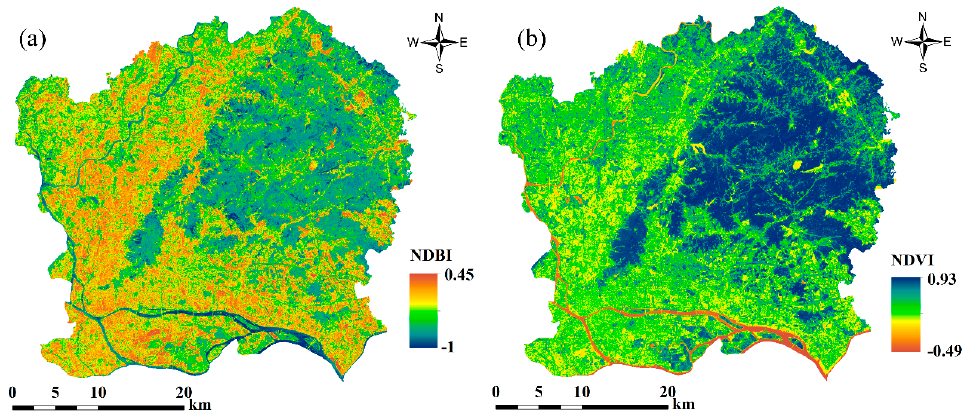
Figure 5. ( a ) Normalized Difference Built ‐ up Index (NDBI); and ( b ) Normalized Difference Vegetation Index (NDVI) maps. Index (NDVI)